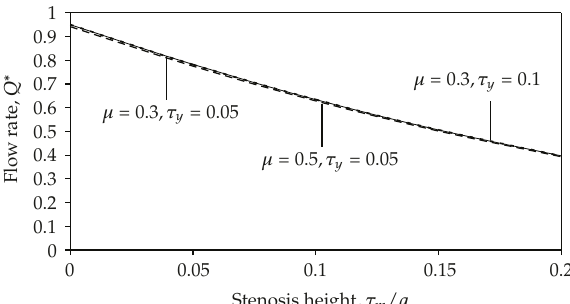
Figure 7: Variation of flow rate with the stenosis height for di ff erent values of μ and τ y at t (cid:7) 0.5 with z (cid:7) 15, τ y (cid:7) 0.1, and τ m (cid:7) 0.1 a